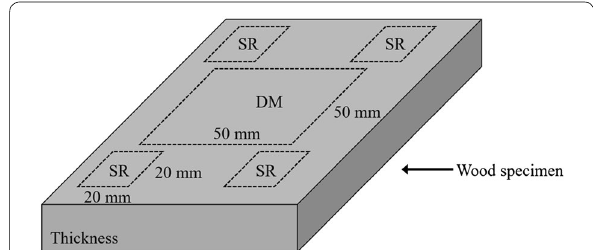
Fig. 3 Illustration of the sampling presenting one specimen: DM for hardness measurement, and SR for equilibrium moisture experiment and set-recovery